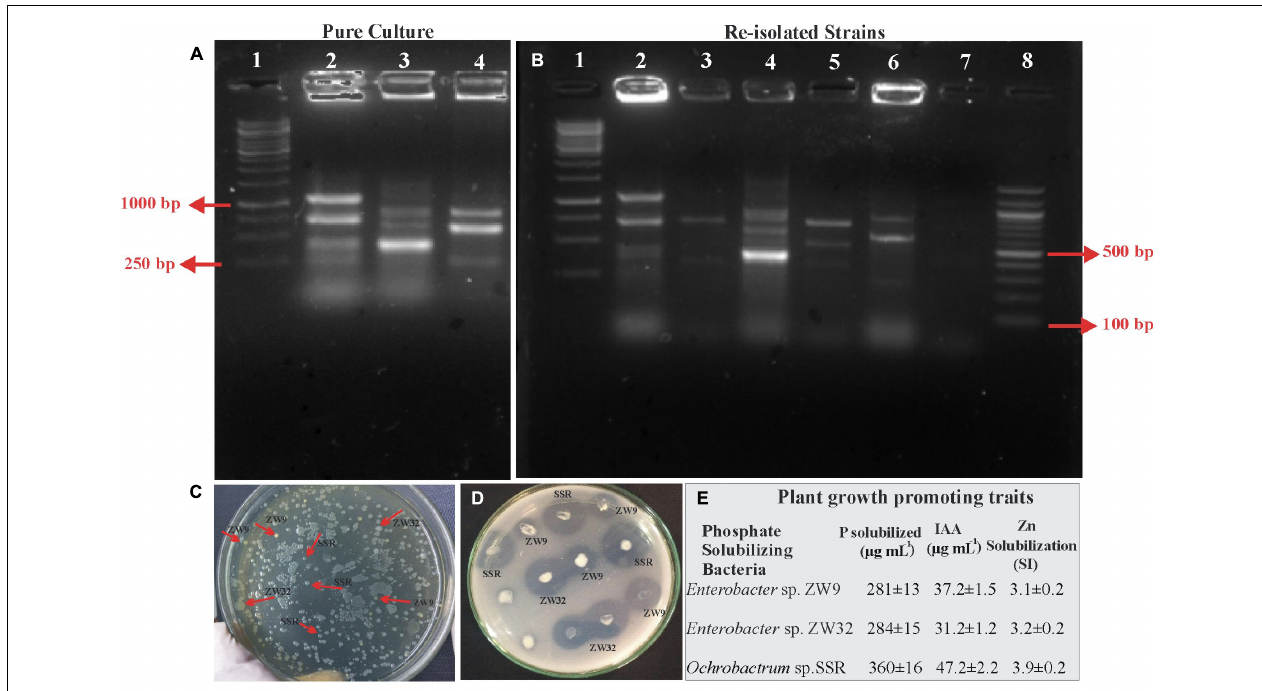
FIGURE 9 | Re-isolation of inoculated PSB colonies. Photograph of gel indicates BOX PCR patterns of pure culture of PSB from wheat rhizosphere, 1: 1Kb DNA ladder; 2: SSR, 3: ZW32, 4: ZW9 (A) . Photograph of gel indicates re-isolated colonies of PSB that are similar morphologically to the inoculated consortium-1 PSB. 1: 1Kb DNA ladder, 2: Re-isolated SSR colony, 3: Non-specific colony, 4: Re-isolated ZW32 colony, 5: Re-isolated ZW9, 6: Non-specific colony, 7: -ve Control; 8: 100 bp DNA ladder (B) . Plate showing re-isolated colonies of SSR, ZW32, and ZW9 (C) . NBRIP Plate showing solubilization zones formed by re-isolated colonies of SSR, ZW32, and ZW9 (D) . Plant growth-promoting attributes of re-isolated PSB strains for confirmation of inoculated PSB: P solubilization and IAA production were detected quantitatively by HPLC, and Zinc solubilization was confirmed by formation of halo zone on agar plate added with ZnO (E) . Values are an average of six biological replicates. Enterobacter spp. ZW9, ZW32, Ochrobactrum sp. SSR, -ve control represents negative